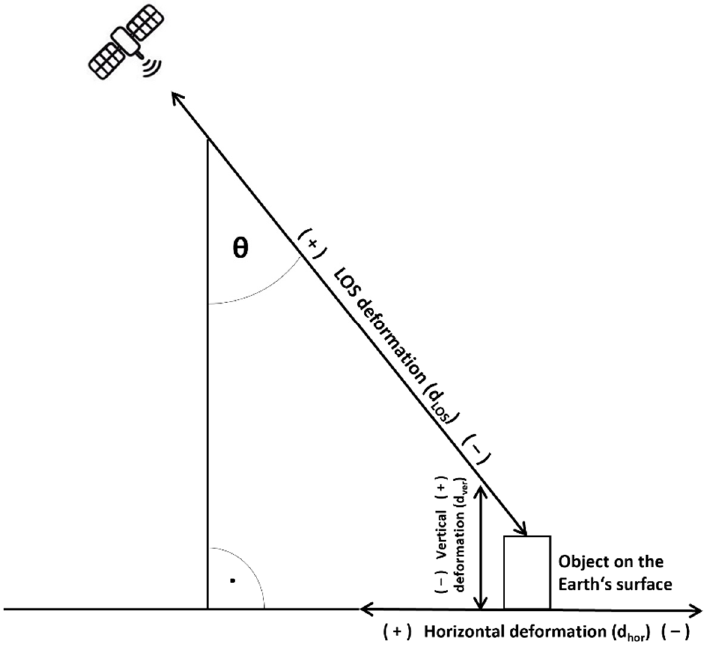
Figure 4. Illustration of the computation of the horizontal deformation in this study.